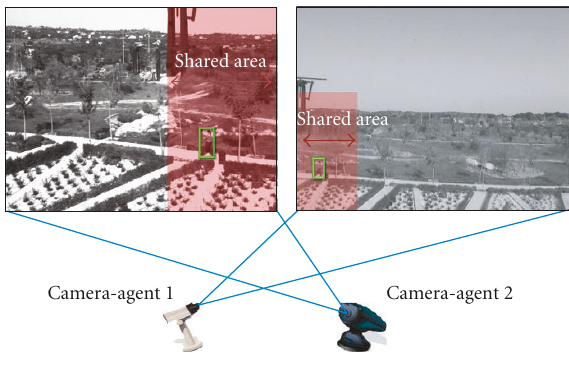
Figure 17: Layout for scenario 2. There are two camera-agents sharing an overlapping zone labelled as “shared area.”